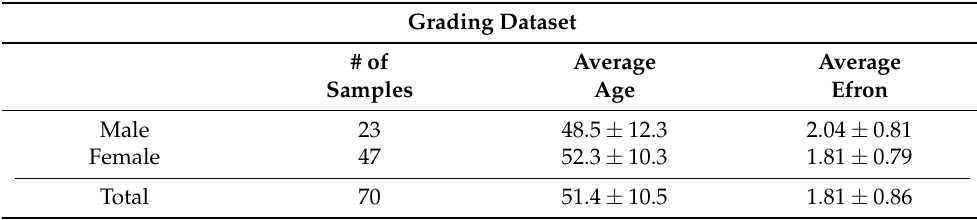
Table 1. Descriptive statistics of the analyzed samples in the dataset. Age and Efron grading values are reported as mean ± standard